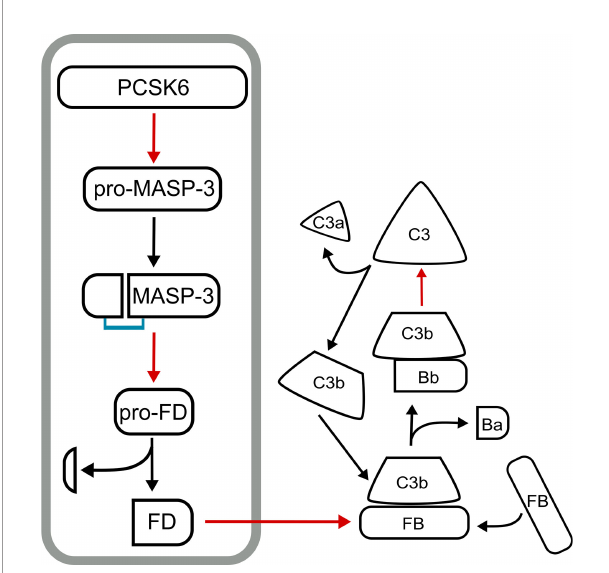
FIGURE 4 | The PCSK6-MASP-3-FD axis. The proenzyme form of MASP-3 (pro-MASP-3) is constitutively activated in the blood by PCSK6 (PACE4). Active MASP-3 cleaves pro-factor D (pro-FD) also constitutively. These two cleavage events are required to keep the alternative pathway of complement ready for action on appropriate surfaces. The PCSK6-MASP-3-FD axis is in a grey box, while subsequent events of the alternative pathway following FD activation are shown on the right. Red arrows point from a protease to its substrate, while black arrows indicate conversion.